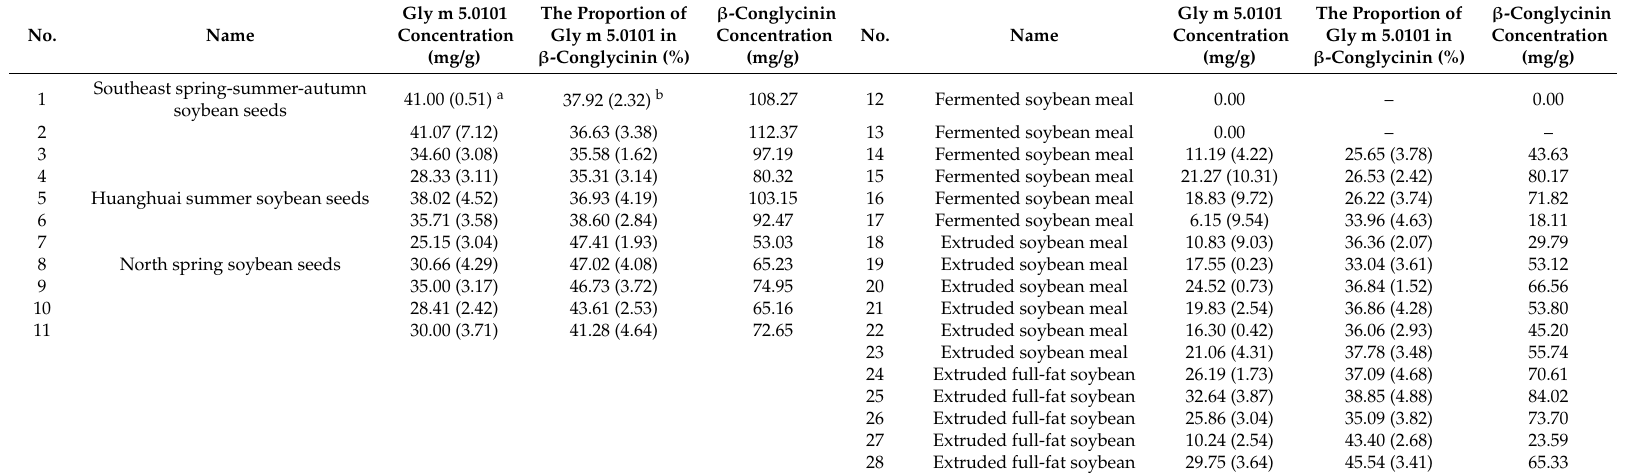
Table 2. Concentrations of Gly m 5.0101 and β -conglycinin in actual soybean samples from soybean seeds and soybean